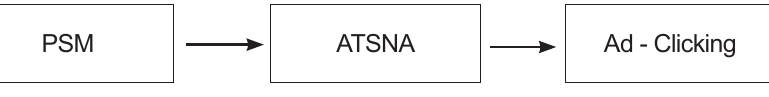
Fig. 1 – Attitudinal Model of SNA. Source: